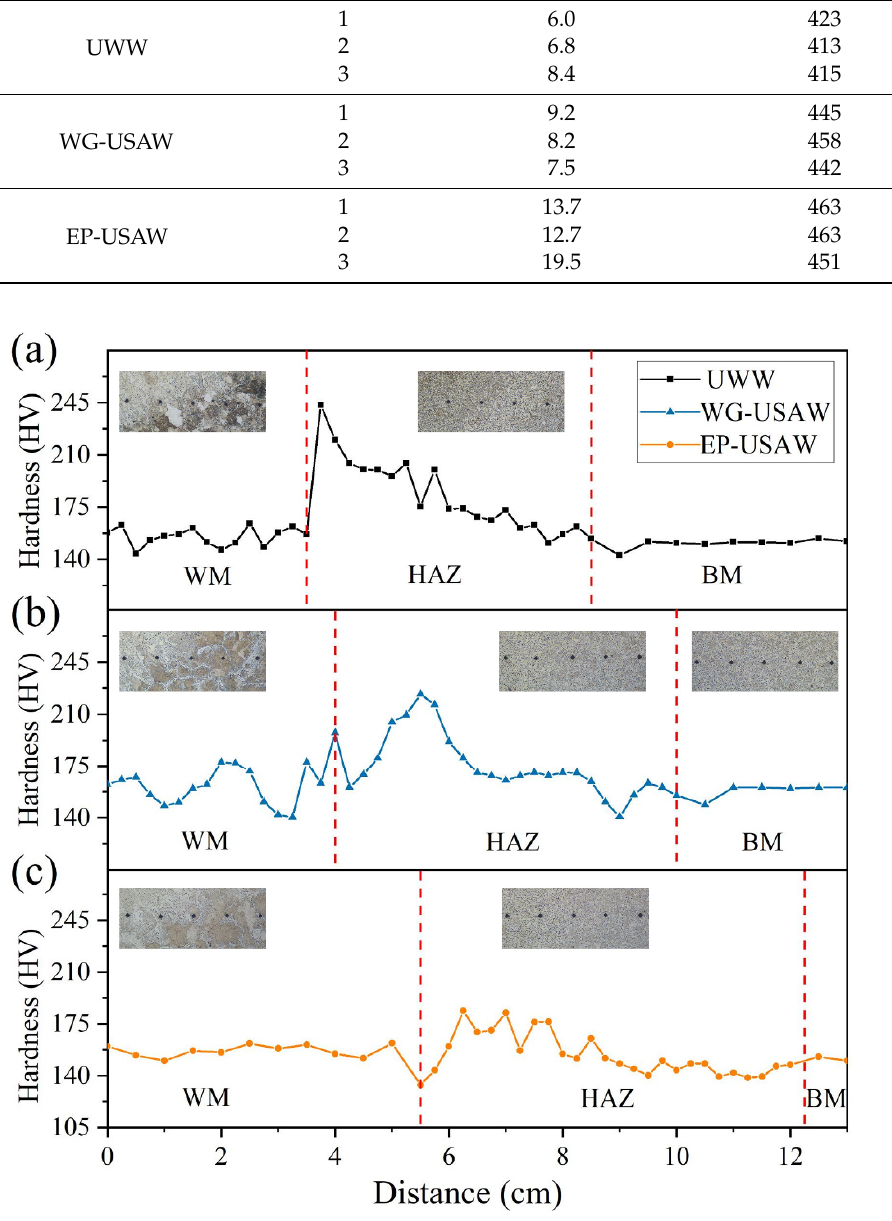
Figure 8. Vickers hardness distributions of welded joints. ( a ) UWW, ( b ) WG-USAW and ( c ) EP-